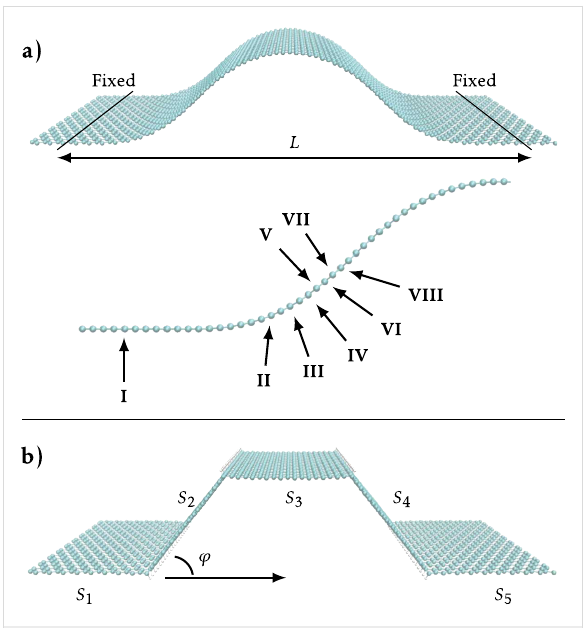
Figure 1: (a) Smooth ripple-like structure where the first and last six rows of carbon-dimers are surface-clamped regions with a separation of L = 90 Å. Atomic hydrogen is adsorbed at positions I–VIII. (b) The resulting kinked graphene structure after hydrogen is adsorbed in lines at the most reactive position (II) corresponding to the smallest local radius of curvature. The four kinks divide the structure into five sections, S 1 – S 5